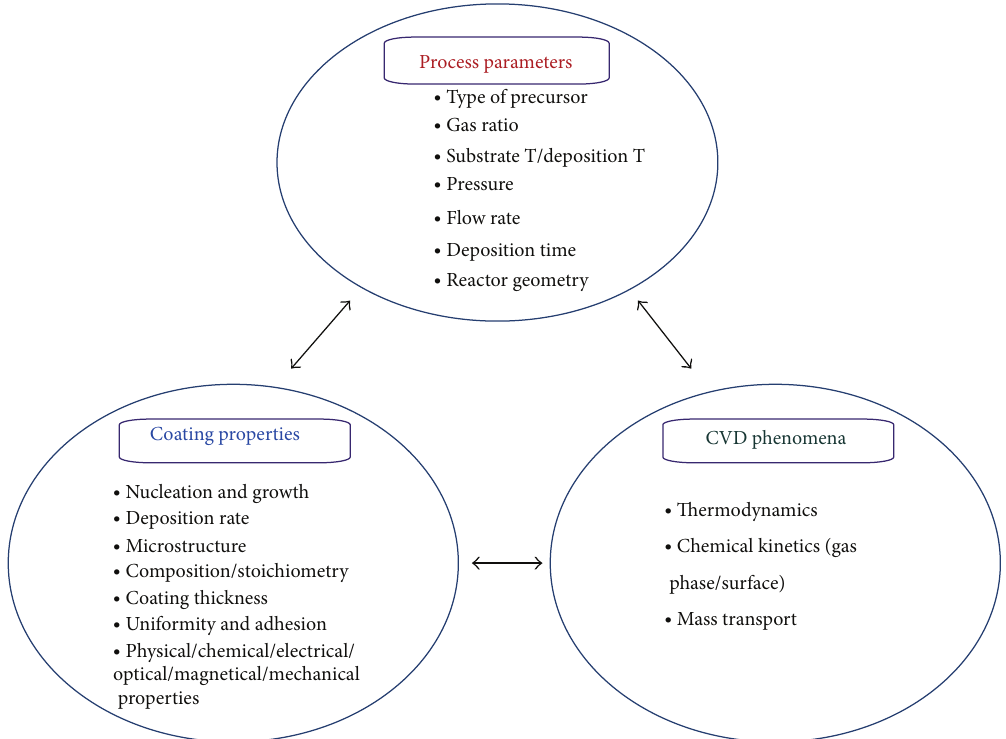
Figure 2: A schematic representation of the relationship of process parameters, CVD phenomena, and coating properties [7].